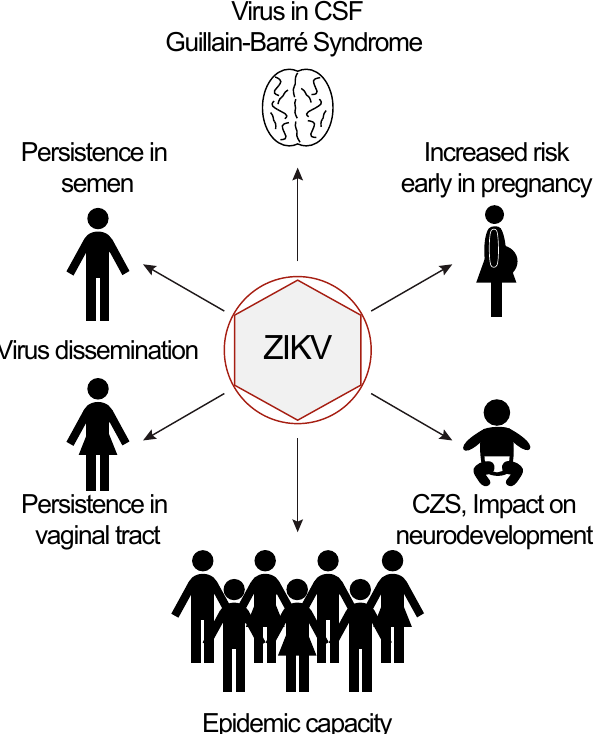
Figure 1. Novel aspects of contemporary Zika virus (ZIKV) outbreaks. Recent ZIKV outbreaks have highlighted the novel epidemic capacity of the virus. Furthermore, ZIKV has been shown to